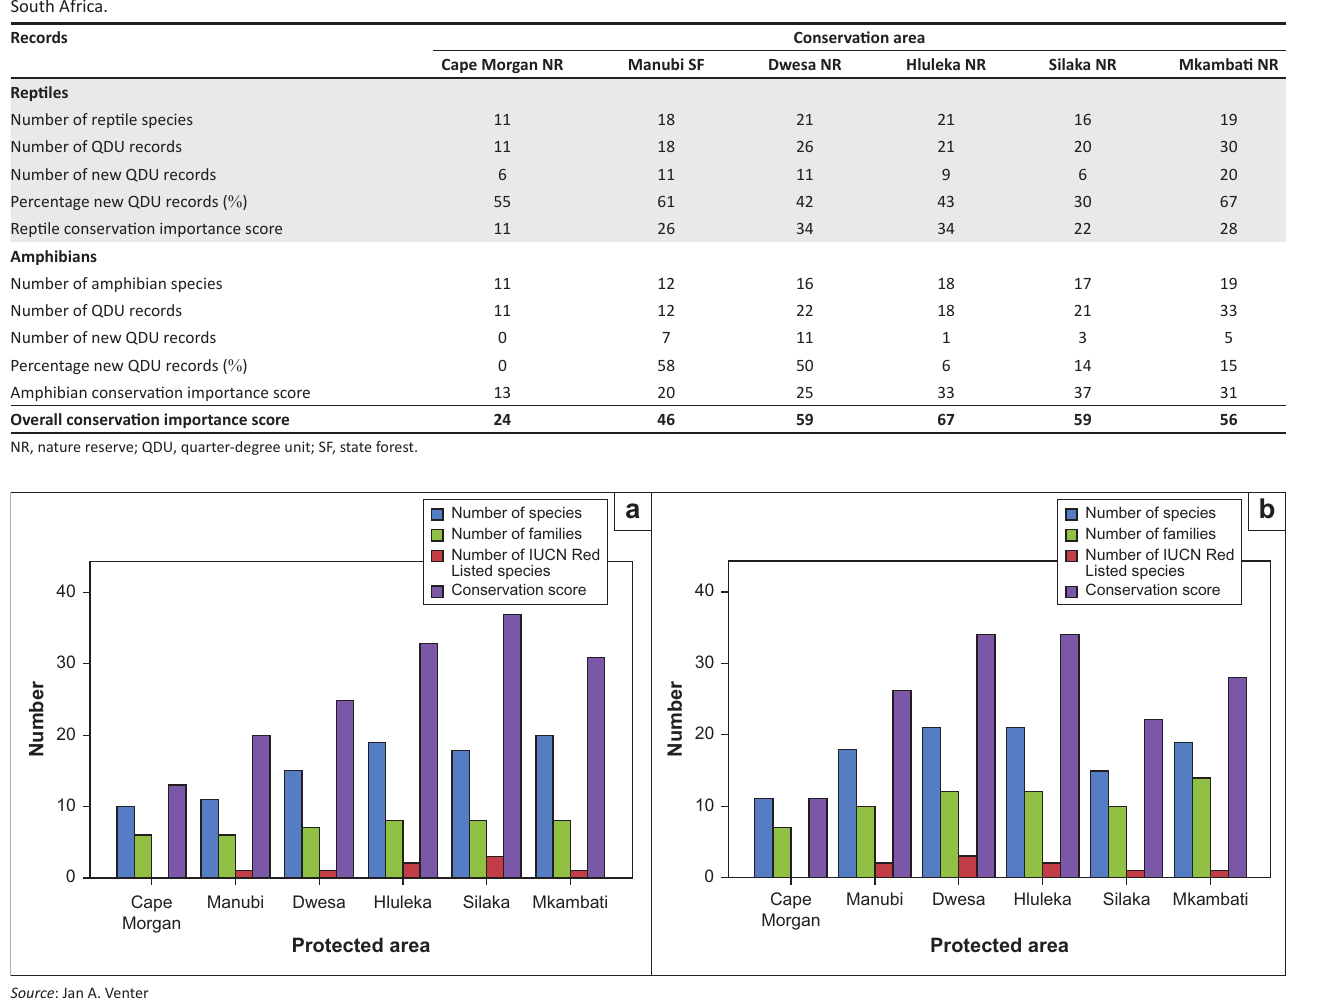
FIGURE 2: A comparison of the number of (a) amphibian and (b) reptile species and families and number of IUCN Red Listed species, as well as the conservation importance scores recorded in the six protected areas during the